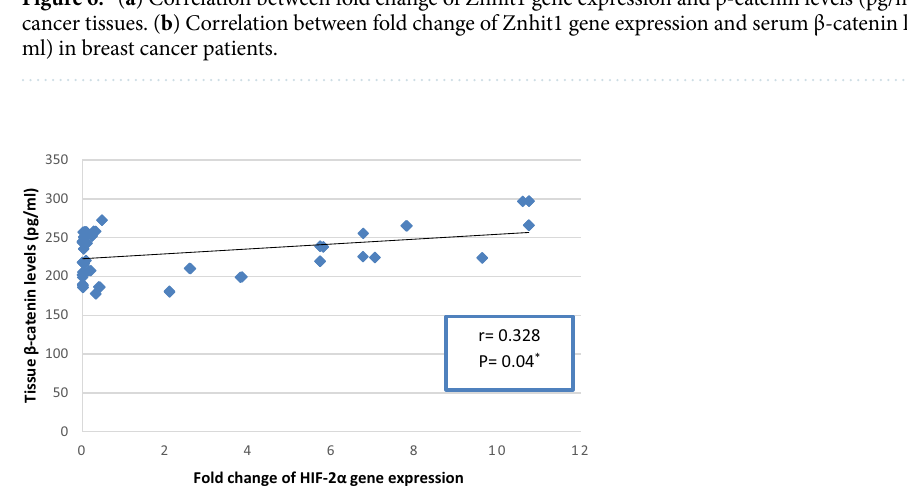
Figure 7. Correlation between fold change of HIF-2α gene expression and β-catenin levels (pg/ml) in breast cancer